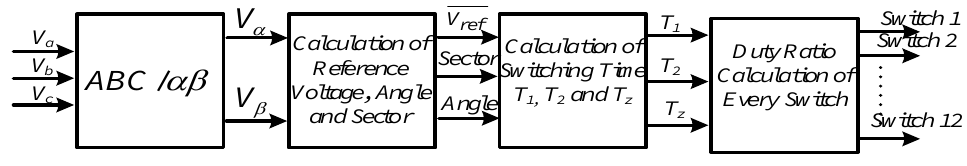
Figure 4. SVM Control Scheme for MSI.